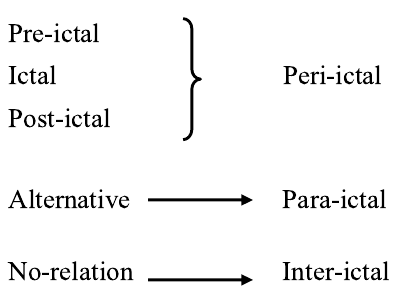
Fig. 1. Classification of psychiatric symptoms according to their temporal relation with